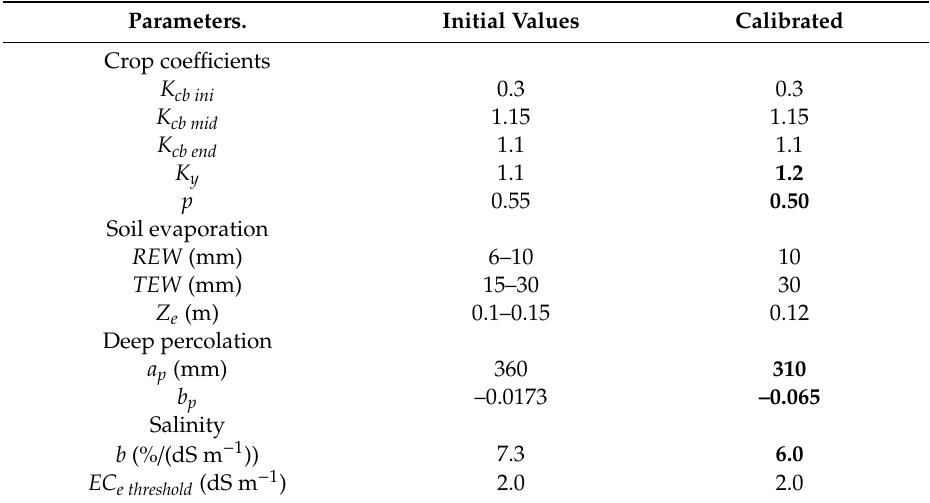
Table 1. Initial and calibrated values for the crop and soil parameters in the SIMDualKc model. Parameters. Initial Values Calibrated Crop coe ffi cients K cb ini 0.3 0.3